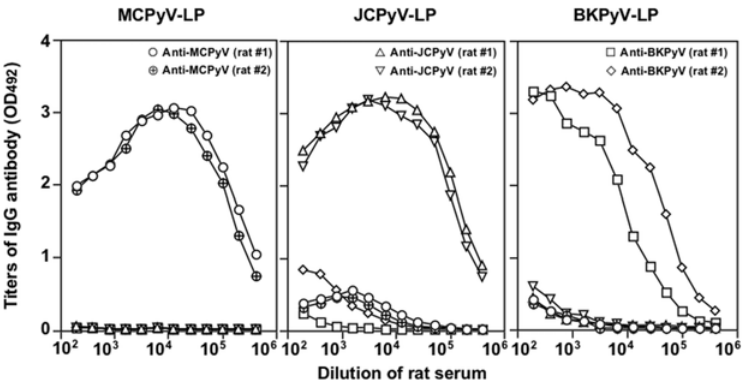
Fig 4. Antigenic cross-reactivity among MCPyV-, BKPyV- and JCPyV-LPs. Hyperimmune sera were obtained from rats that were immunized with MCPyV-, BKPyV- and JCPyV-LPs, respectively. Titers of anti- MCPyV-, BKPyV- and JCPyV-LP-IgG were determined by